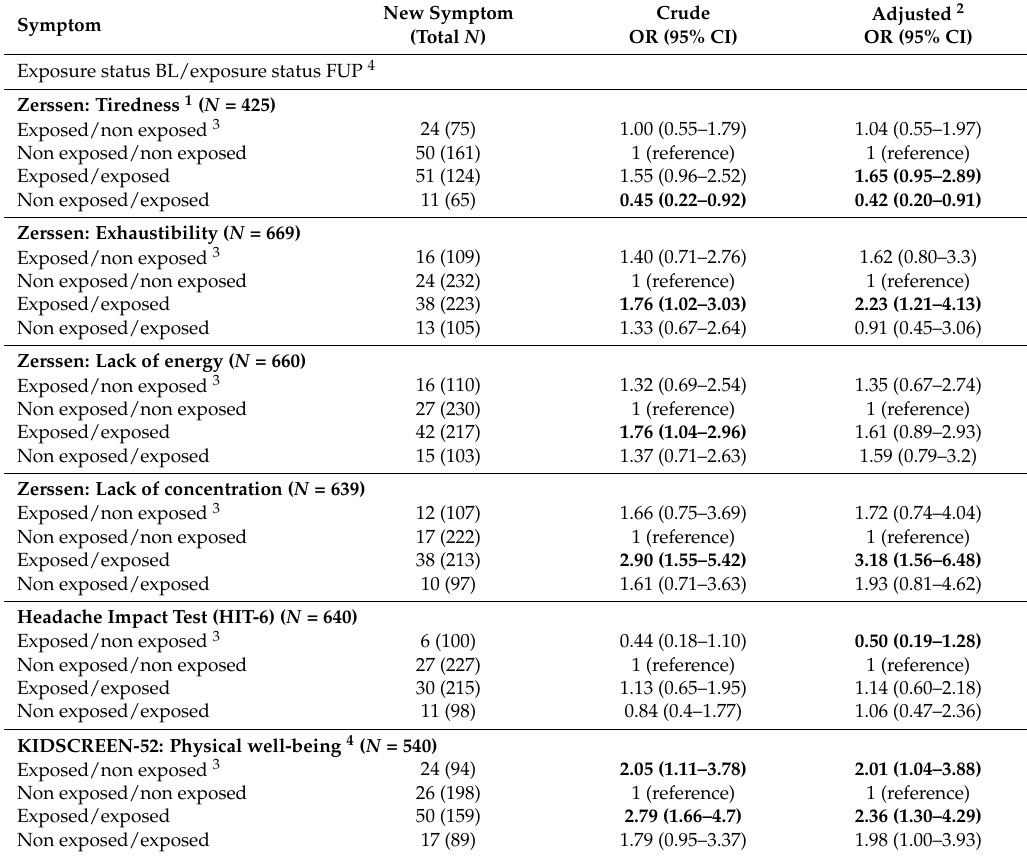
Table 5. OR to develop symptoms between BL and FUP in relation to total screen time. Significant associations are displayed in